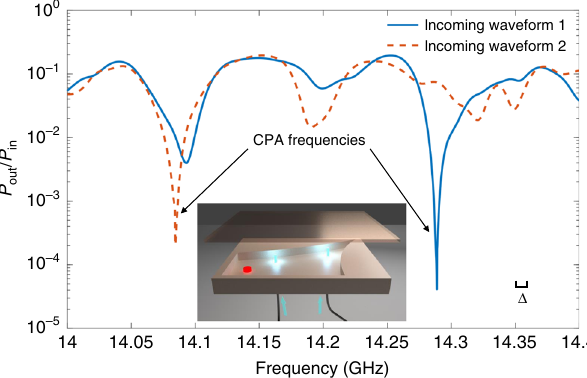
Fig. 5 Demonstration of two CPA states in the quarter bow-tie billiard. A two-dimensional quarter bow-tie billiard (see inset) is used to test the CPA protocols. The red dot on the bow-tie represents the location of a point-like variable loss in the cavity. Through analysis of the S -matrix, two CPA states are found at the same system con fi guration. By injecting two different CPA waveforms, the measured ratios of output power P out to input power P in as a function of the microwave frequency are plotted together. The different incoming waveforms support two different CPA states with different CPA frequencies. The scale bar of the mean mode spacing Δ is shown in the plot as